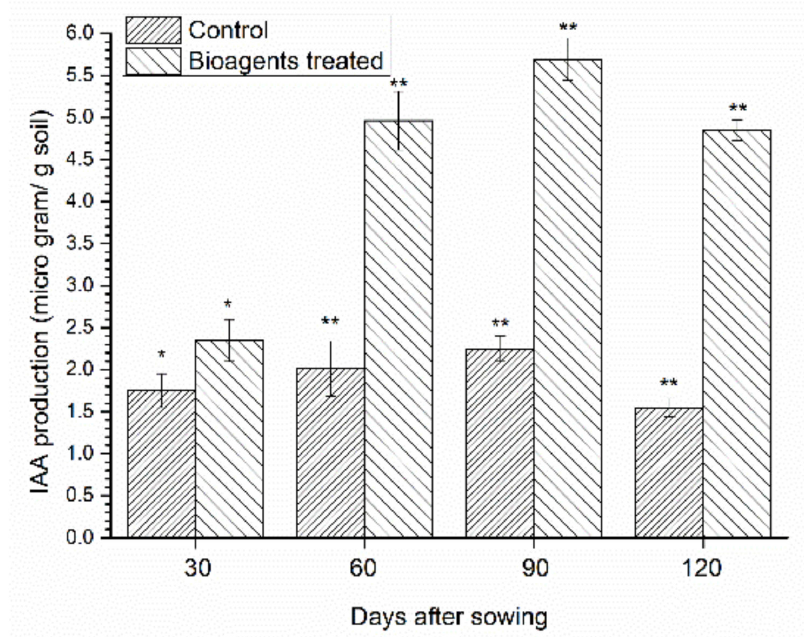
Figure 1. Effect of T. harzianum UBSTH-501 and B. amyloliquefaciens B-16 inoculation on IAA produc- tion in the wheat rhizosphere at 30, 60, 90, 120 DAS. Data are means and vertical bar lines represent standard deviation. Double asterisk (**) represents significant difference, while single asterisk (*) represents non-significant difference with their respective